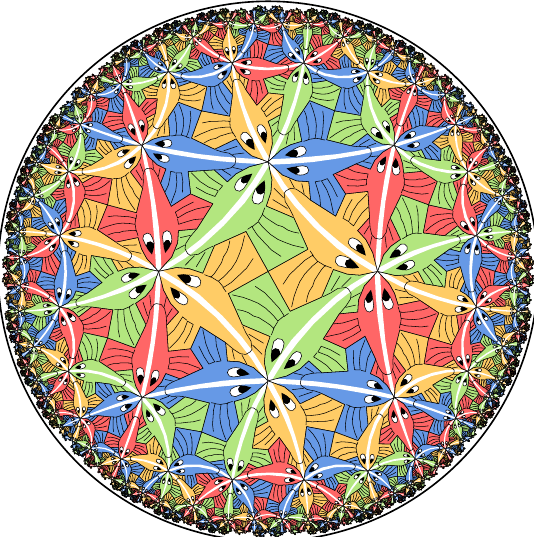
Figure 1 . Representation of the hyperbolic plane on the Poincaré disk. White lines denote boundary-anchored geodesics. The piling up of fish at the boundary indicates that lengths be- come infinite as they approach it. (Figure from https://www.d.umn.edu/~ddunham/dunbrid07.pdf , modeled on Circle Limit III , M.C. Escher,